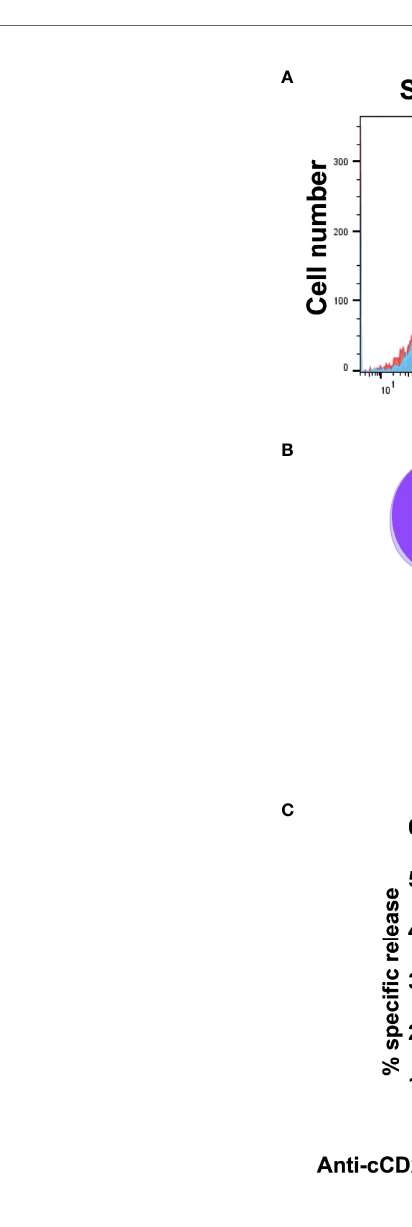
FIGURE 4 | NK-92 cells expressing canine CD16A mediate ADCC. (A) SKOV-3 parental cells and SKOV-3-canine CD20 (cCD20) cells were stained with an anti- canine CD20 mAb or an isotype-matched negative control mAb (control) and examined by fl ow cytometry. (B) Schematic representation of ADCC. SKOV-3-canine CD20 cells treated with a caninized anti-canine CD20 mAb in the presence of NK-92 canine CD16A (cCD16A) cells. (C) NK-92 canine CD16A cells were incubated with SKOV-3 canine CD20 cells at the indicated E:T ratios in the presence or absence of a caninized anti-canine CD20 mAb for 2 h at 37 °C. Data are represented as % speci fi c release and the mean ± SD of 3 independent experiments is shown. Statistical signi fi cance is indicated as ****p <